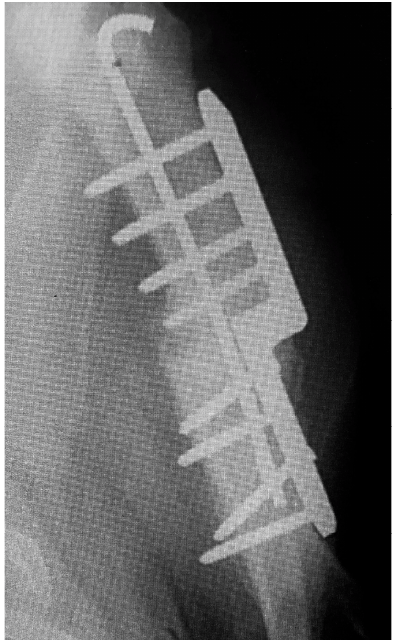
Figure 2. Post-operative view of the repair.